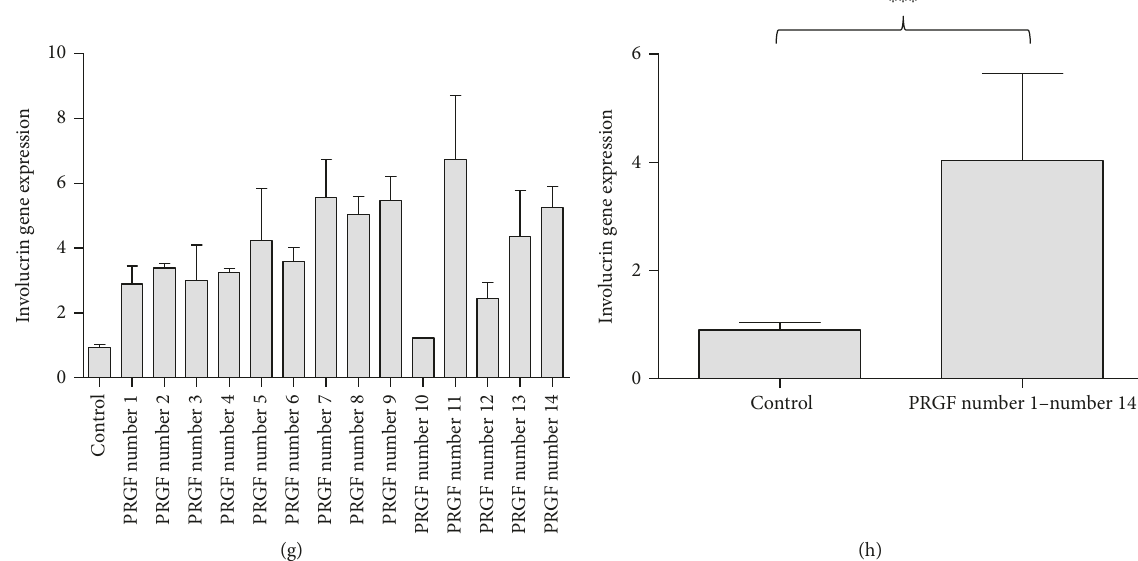
Figure 3: PRGF from di ff erent donors in fl uenced gene expression of di ff erentiation markers in a similar manner. Analyzing the capacity of PRGF from 14 di ff erent donors (PRGF number 1 – PRGF number 14), we observed a strong and interindividually di ff erent e ff ect of the used PRGF on the expression of keratin 1, keratin 10, transglutaminase-1, and involucrin in primary keratinocytes (a, c, e, g). The mean values of all 14 PRGFs analyzed (b, d, f, h) revealed a signi fi cant in fl uence of the PRGF treatment on the gene expression of the analyzed di ff erentiation markers in primary human keratinocytes (real-time PCR analysis, ∗ P < 0 05 , ∗∗∗ P < 0 001 , ∗∗∗∗ P < 0 0001 , Student ’ s t